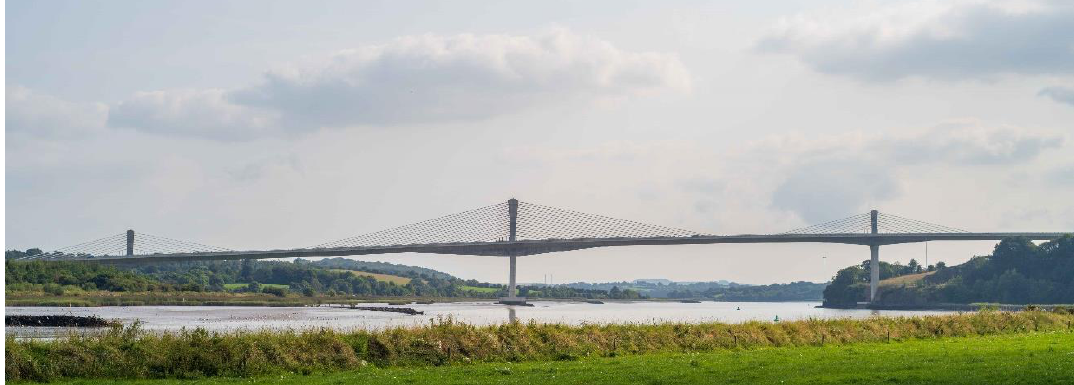
Figure 2. View of the Rose Fitzgerald Kennedy Bridge.